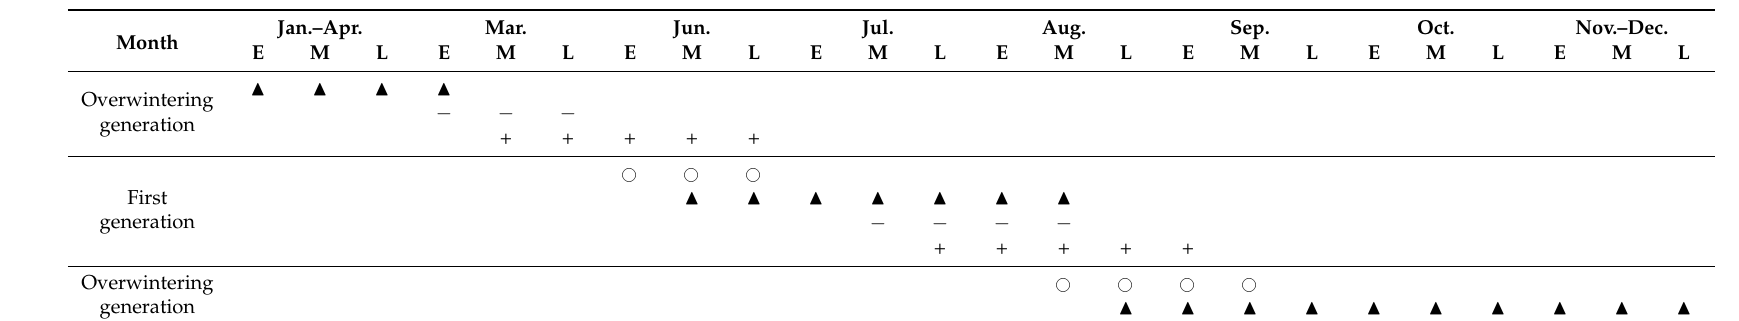
Table A6. The life cycle of T.